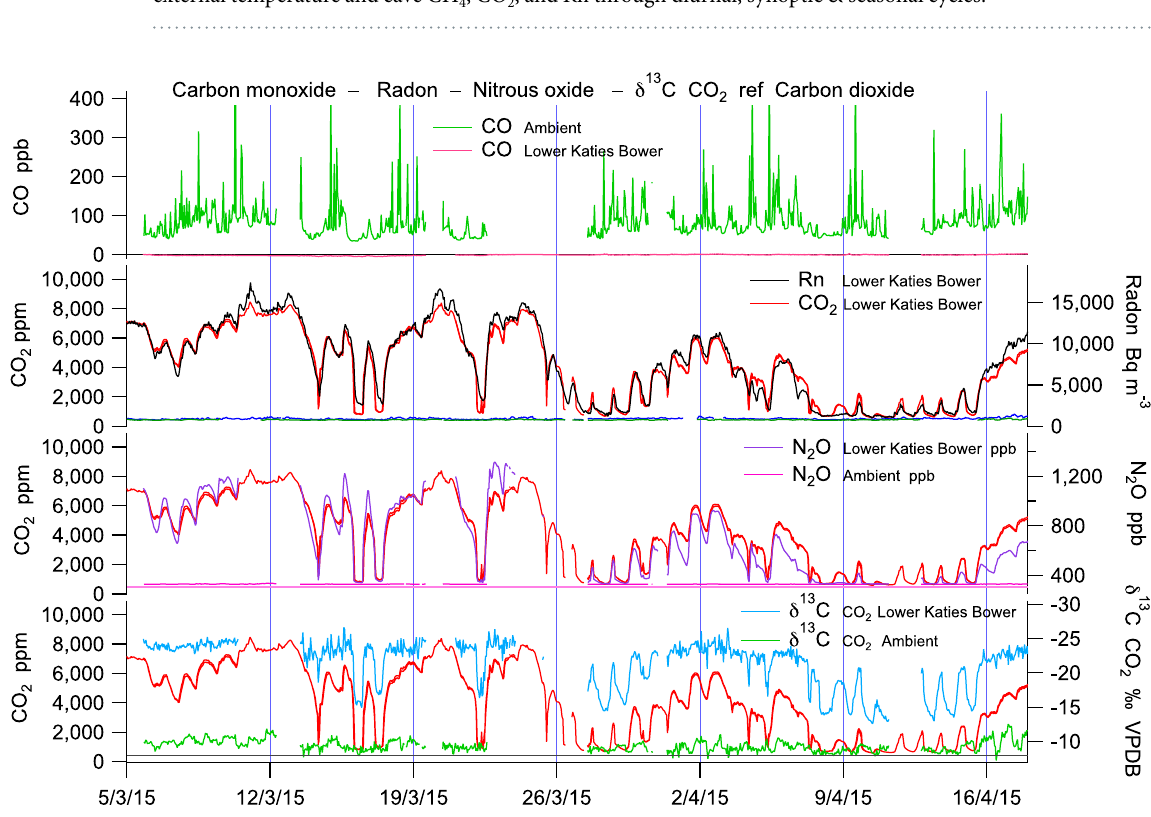
Figure 4. Late summer time series of CO, CO 2 , Rn, N 2 O, and δ 13 C – CO 2 from Lower Katies Bower corresponding with correlation plots (5/3/15–18/4/15). CO is totally depleted (measurement error ± 5 ppb) within Chifley Cave relative to a variable background ambient concentration of 75–110 ppb. CO depletion is not seasonally variable. Rn, N 2). Late summer bi-directional air-flow shows large synchronous fluctuations in CO 2 and gas